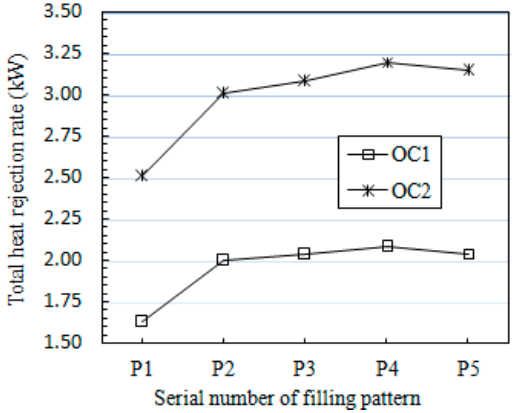
Figure 4. Relationship curves between total heat rejection and filling layout patterns. OC1: Operating conditions 1 (50 °C, 6 L/min); OC2: Operating conditions 2 (60 °C, 6 L/min).